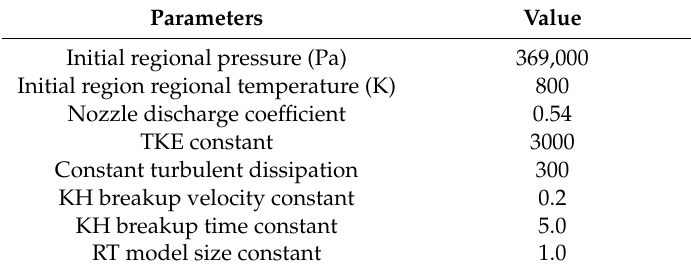
Table 3. Setups of major parameters in the CFD